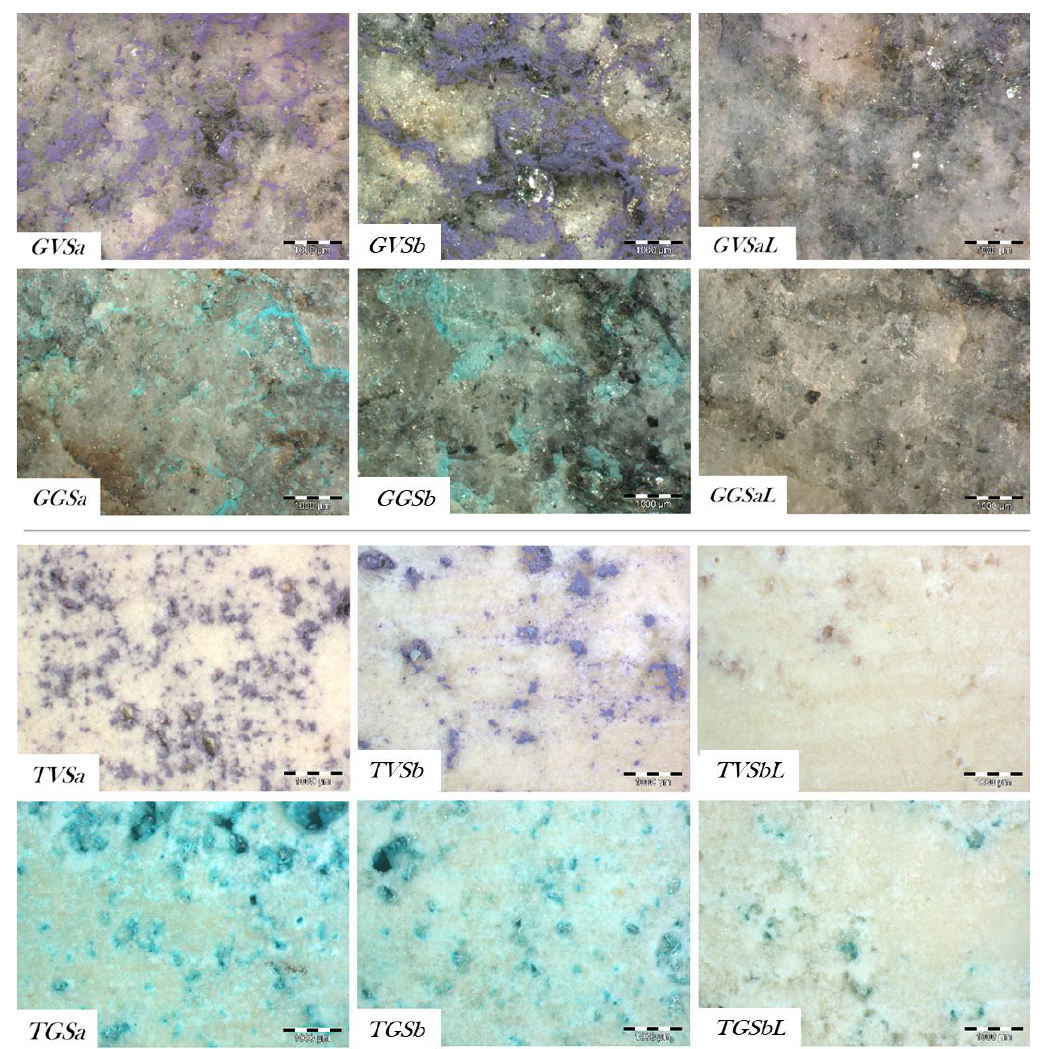
Figure 3. Micrographs taken by stereomicroscope of the cross sections of the painted samples of travertine. ( a ) Violet paint. ( b ) Green paint.